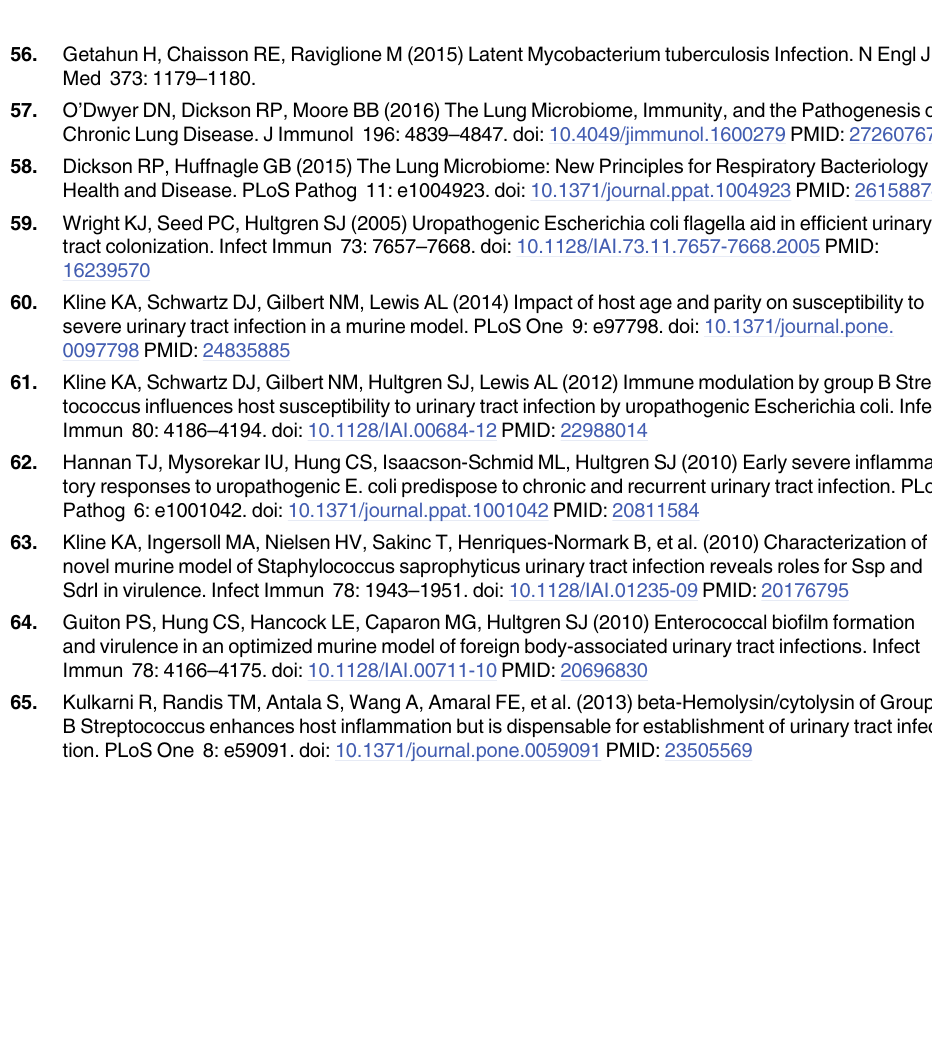
PLOS Pathogens| DOI:10.1371/journal.ppat.1006238 March 30,